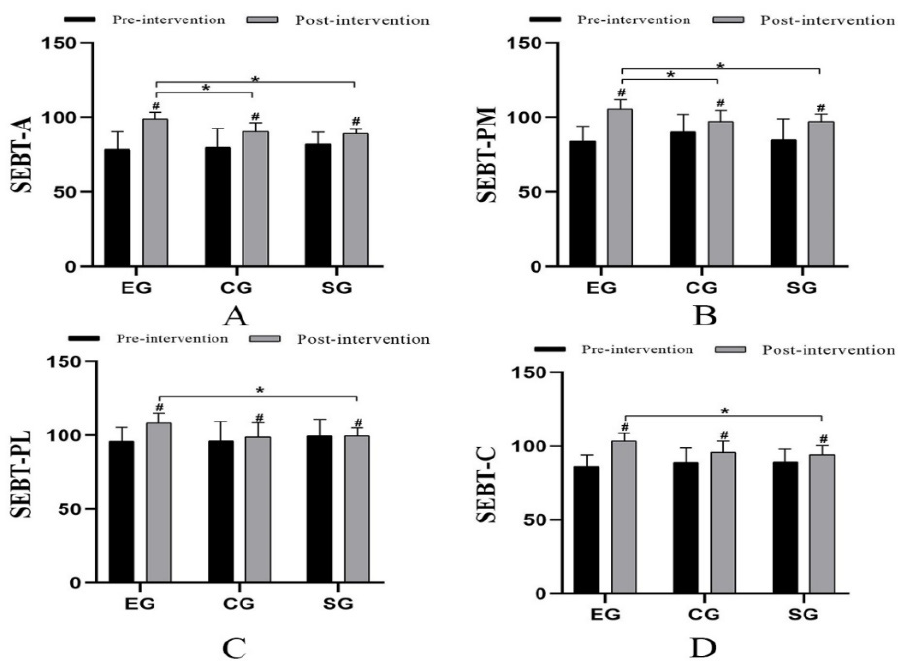
Figure 2. Comparison of SEBT (cm) values among the three groups. # Comparison between groups; * Significant when compared with the EG group ( p < 0.05). ( A ): SEBT-A; ( B ): SEBT-PM; ( D ): ( C ): SEBT-PL; ( D ): SEBT-C.